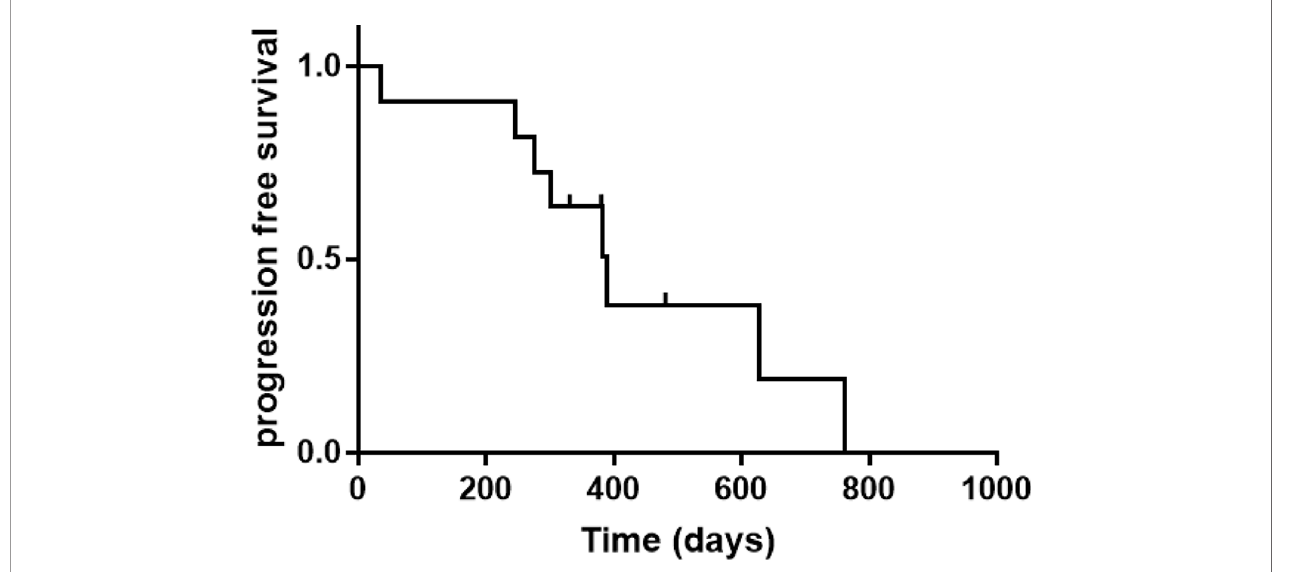
FIGURE 2 | Kaplan-meier curve for survival